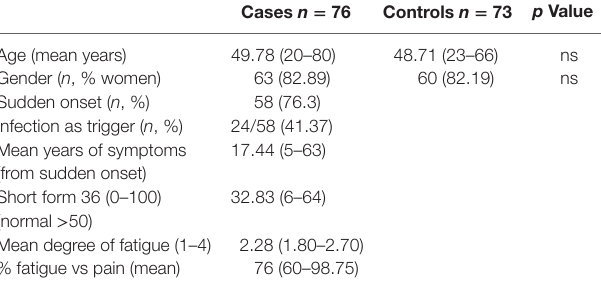
Table 1 | Main demographic characteristics of the